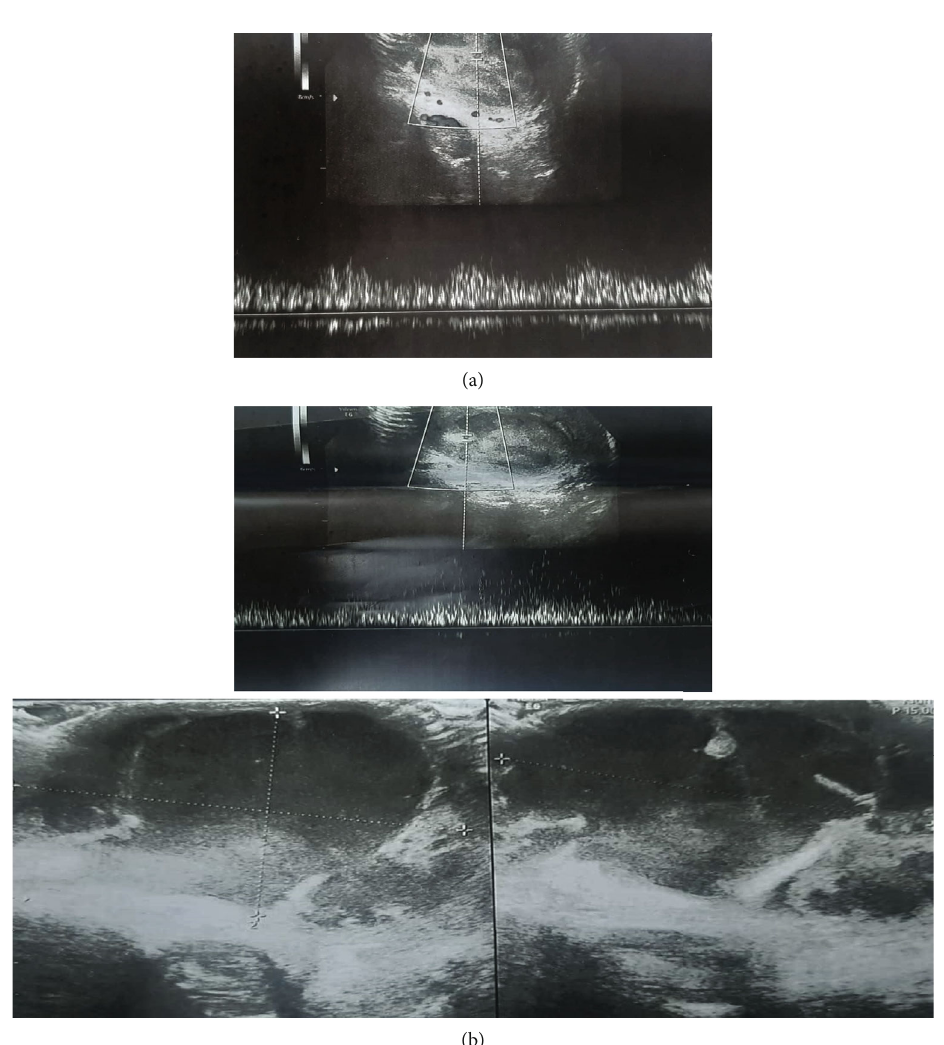
Figure 2: (a) Chest CT and (b) Sonography